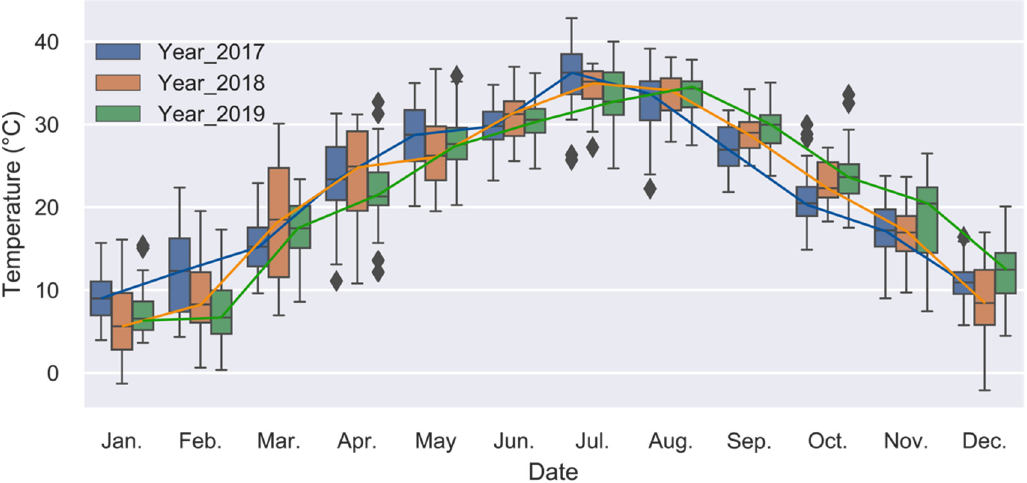
Figure A2. The distribution of maximum daily temperature for three years.